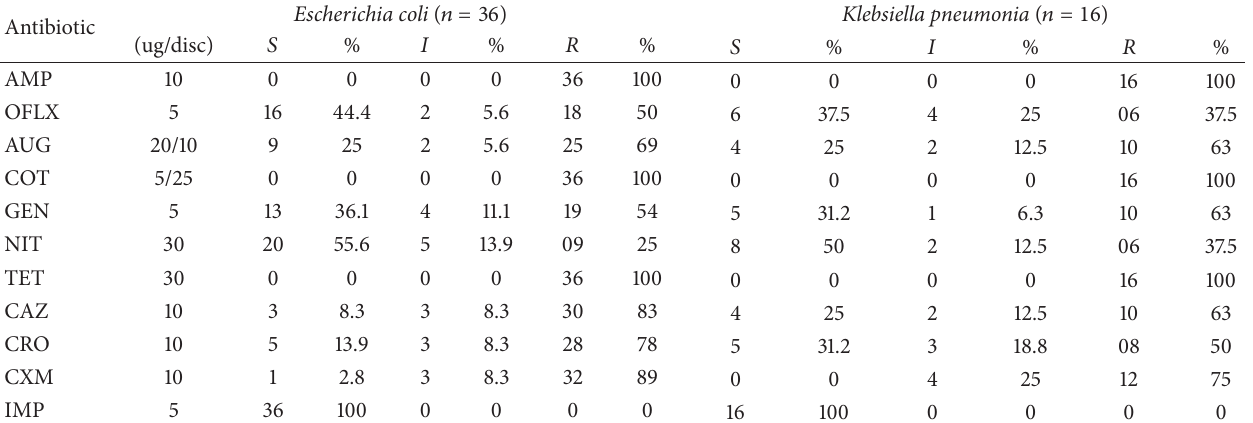
Table 3: Antibiotic susceptibility rate of ESBL isolates obtained from different clinical samples to commonly used antibiotics by disc diffusion test.